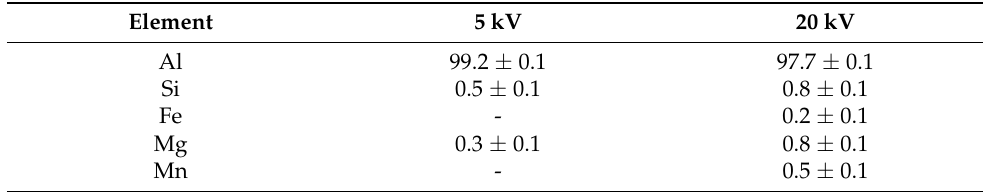
Table 4. Composition of the of Al6082 aluminium after the activation treatment measured with EDS at 5 kV and 20